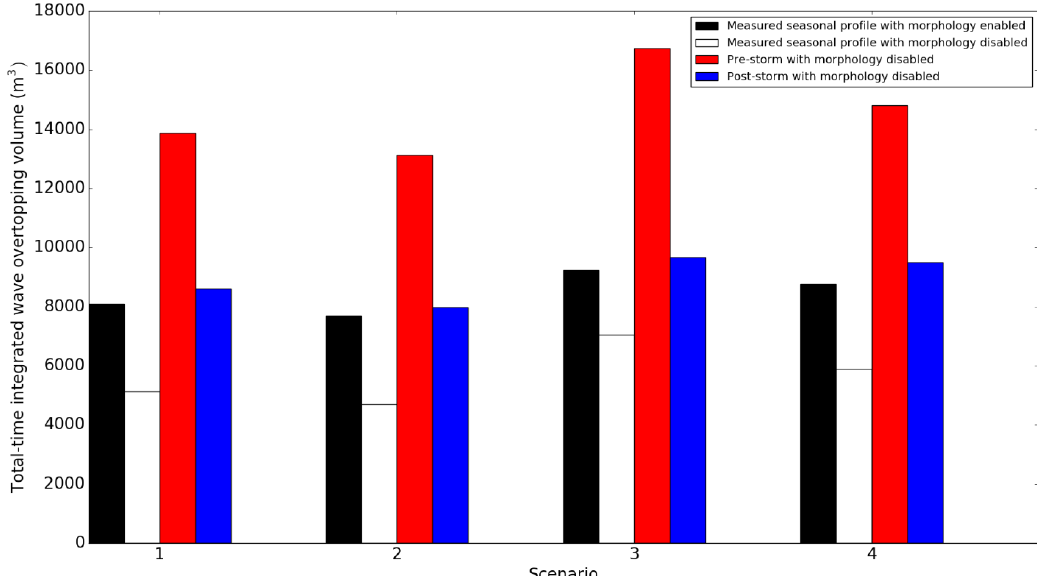
Figure 4. Total time-integrated wave overtopping for each scenario under the applied morphological profiles: measured seasonal profile with morphology disabled, measured seasonal profile with morphology enabled, pre-storm with morphology disabled and post-storm with morphology